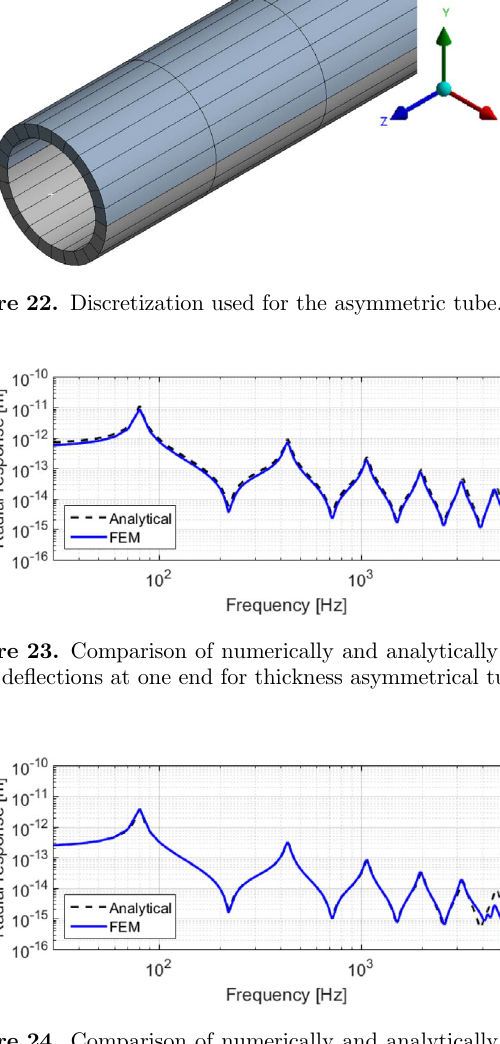
Figure 24. Comparison of numerically and analytically calcu- lated de fl ections at one end for modulus of elasticity asymmet- rical tube.